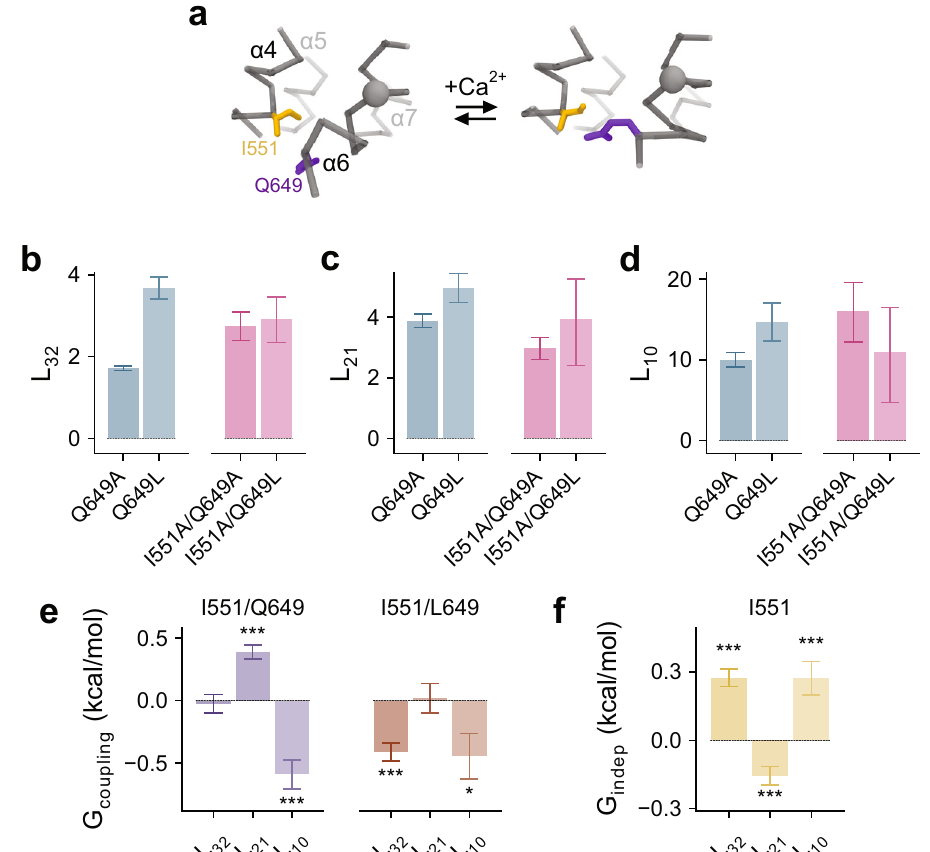
Fig. 4 Mechanistic double-mutant cycle at the α 4 – α 6 interface. a Relation between Ile 551 and Gln 649 in Ca 2 + -free and -bound conformations. Representation is as in Fig. 3a. b – d Equilibrium constants for mutants at the interface for transitions b , L 32 , c , L 21, and d , L 10 . Bars indicate the best- fi t values of the averaged data shown in Supplementary Fig. 7d (Q649A, n = 7; Q649L, n = 7; I551A/Q649A, n = 8; I551A/Q649L, n = 7). Errors are 95% con fi dence intervals. e Coupling energy ( G coupling ) and f independent energetic contribution ( G indep ) of the indicated residues. Bars indicate quantities calculated using e , Eqs. 31 – 32, 35 and f , Eq. 34 from the best- fi t values shown in b – d . Errors correspond to standard errors. Asterisks indicate signi fi cant deviation from zero in a two-sided one-sample t -test ( e I551/Q649: *** p = 2e − 7 and *** p = 3e − 5; I551/L649: *** p = 5e − 6 and * p = 0.023; f *** p = 1e − 7, *** p = 6e − 4, and *** p =